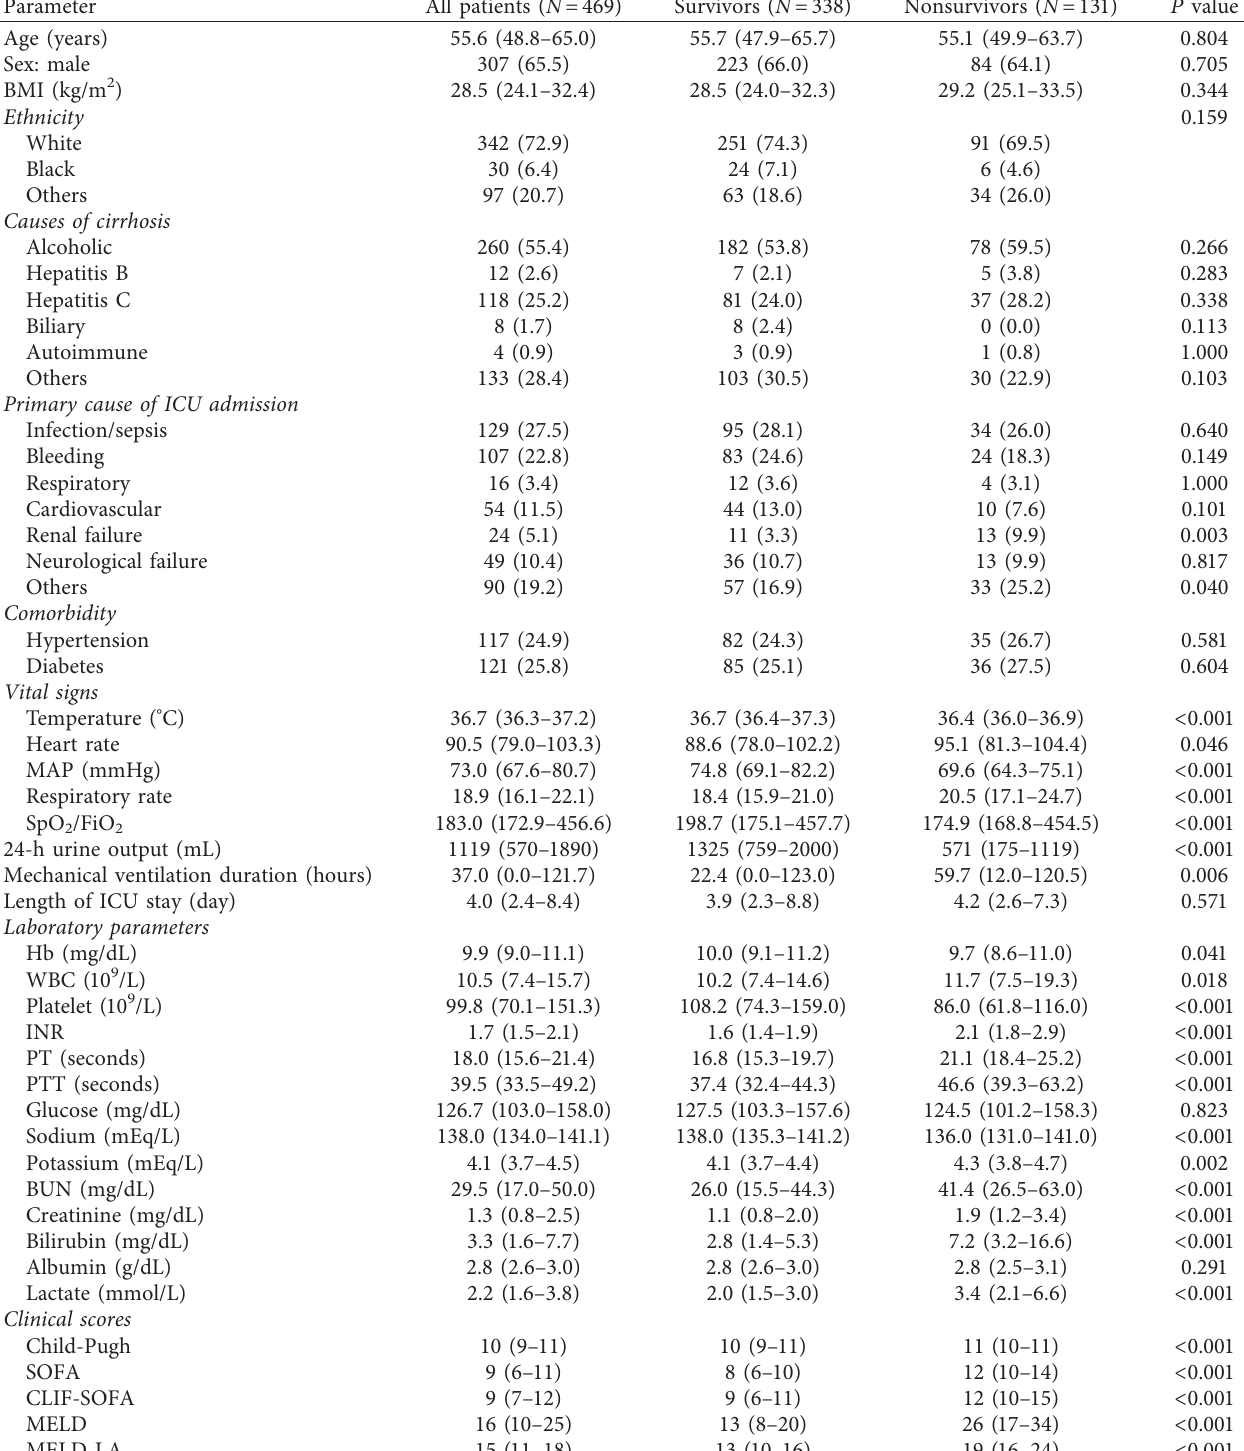
Table 1: Characteristics of the study population, stratified by